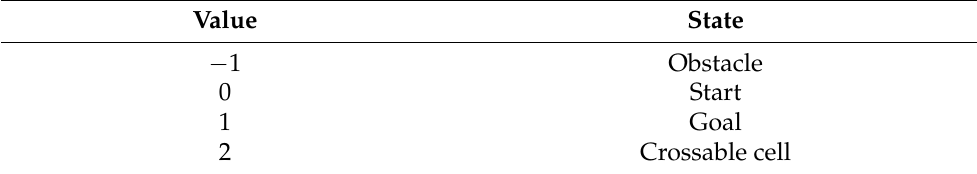
Table 1. Discretization of the